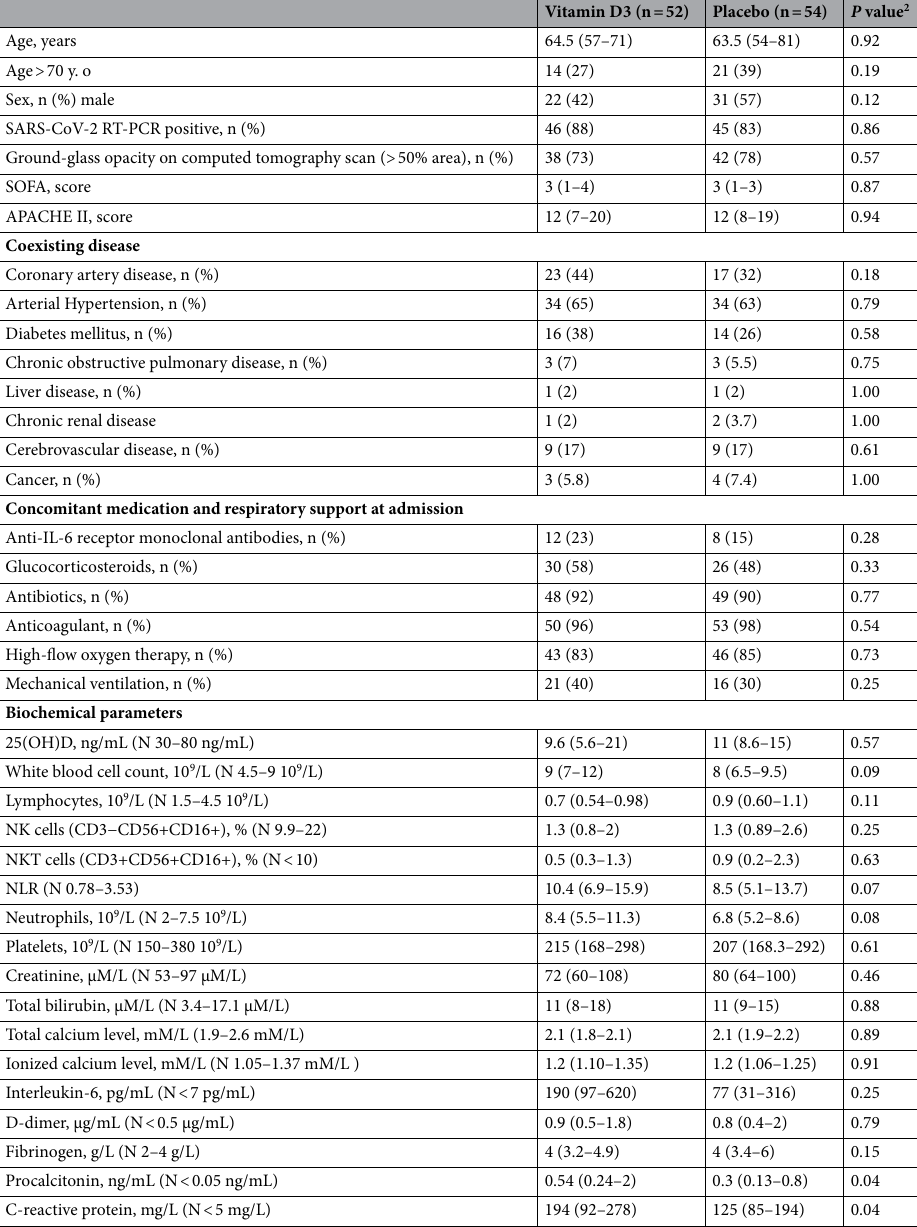
Table 1. Baseline demographic, clinical, and biochemical characteristics of the COVID-19 patients admitted to the ICU 1 . 1 Numerical data are expressed as median (IQR); categorical data are shown as the number of cases (percentage). 2 P values were calculated by Mann–Whitney U test, χ 2 test, or Fisher’s exact test, as appropriate. 3 N, reference range. SARS-CoV-2 RT-PCR positive positive reverse transcription polymerase chain reaction for the Severe Acute Respiratory Syndrome Coronavirus 2, SOFA Sequential Organ Failure Assessment, APACHE II Acute Physiology and Chronic Health Evaluation II, NLR neutrophil to lymphocyte ratio, 25 ( OH ) D serum 25-hydroxyvitamin